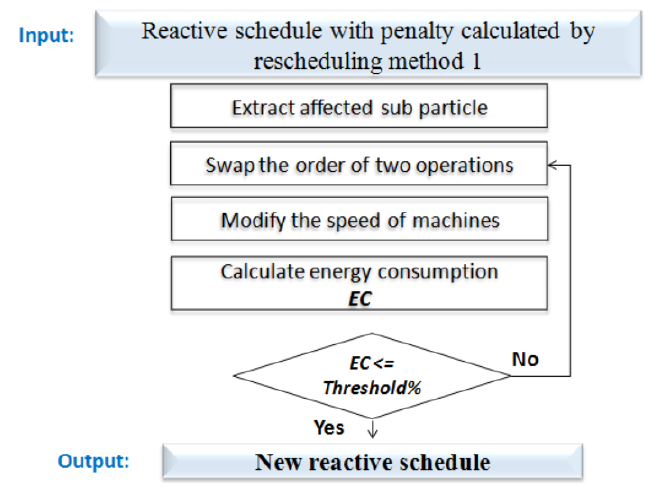
Figure 7. Flow chart of the second rescheduling